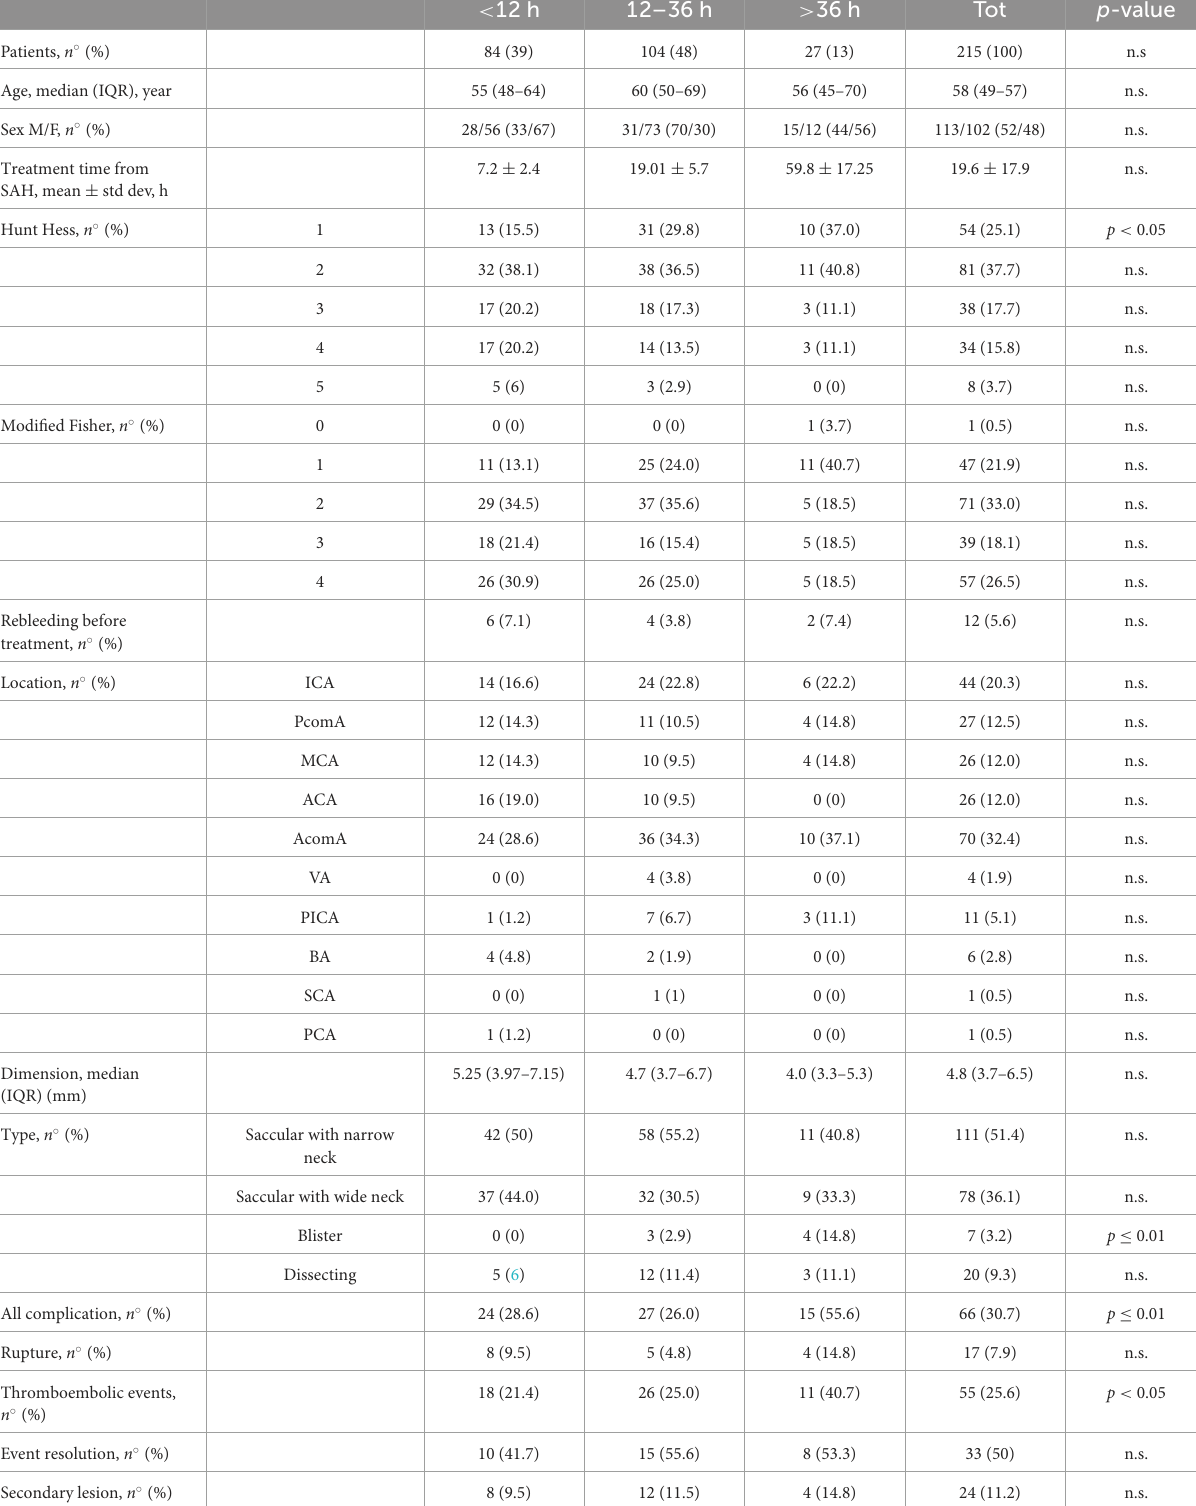
TABLE 1 Demographic and clinical parameters in hyper-early, early, and delayed treatment